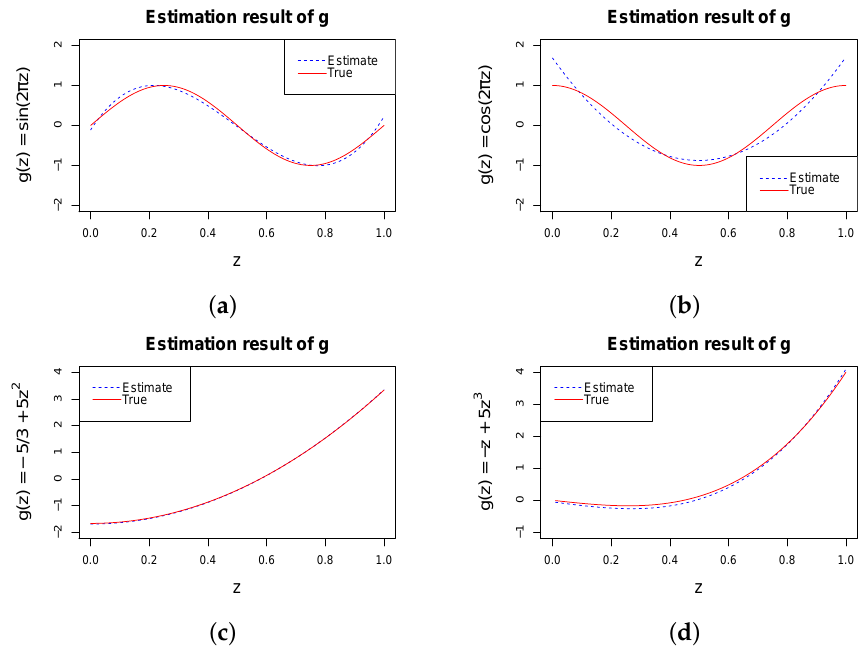
Figure 1. Estimated g with β = 0 and τ = 0.3; the solid red lines represent the real functions and the dashed blue lines show the estimated functions. ( a ) g ( z ) = sin ( 2 π z ) ; ( b ) g ( z ) = cos ( 2 π z ) ; − 5 z 2 ; ( d ) g ( z ) = − z + 5 z 3 ( c ) g ( z ) = 5 3